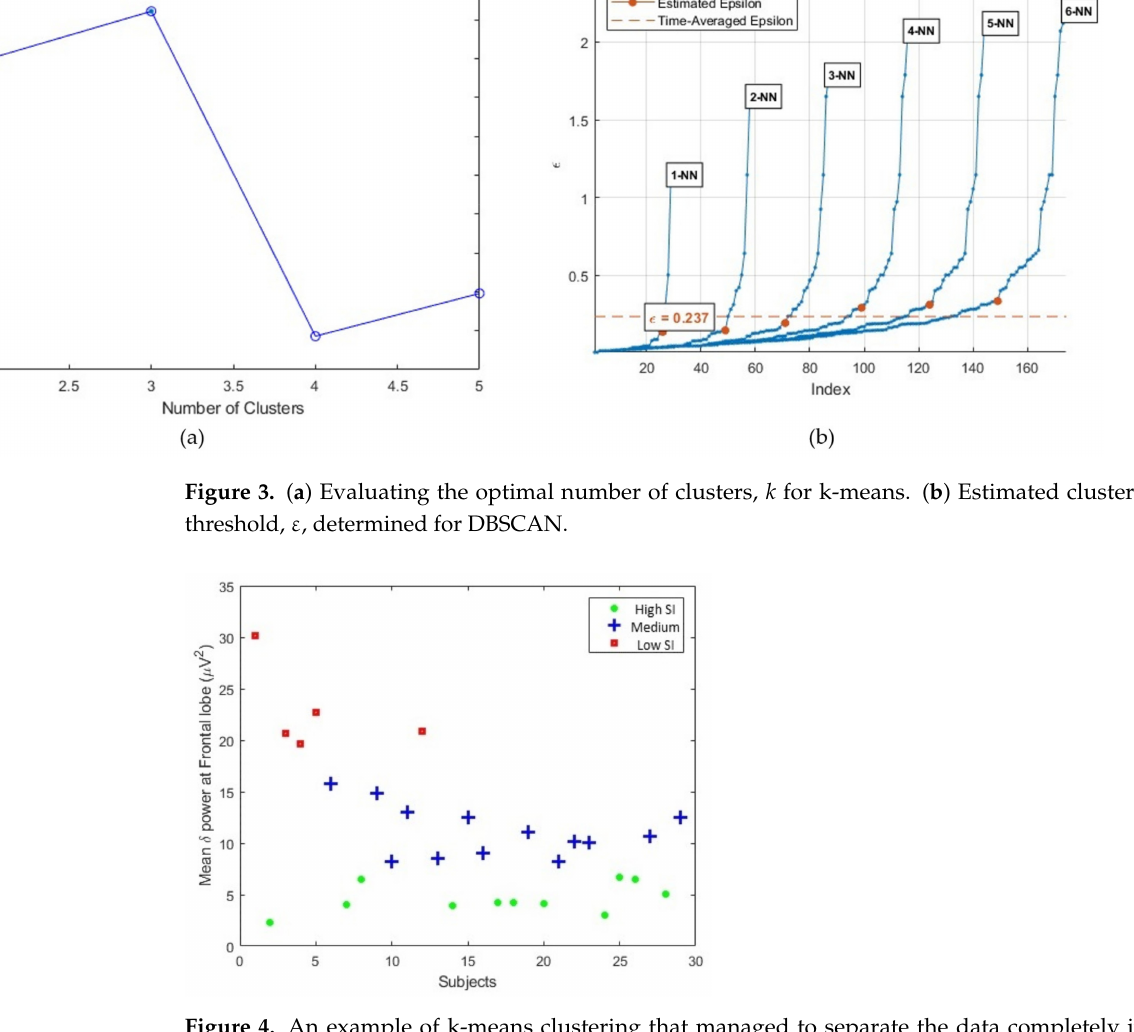
Figure 4. An example of k-means clustering that managed to separate the data completely into three clusters.